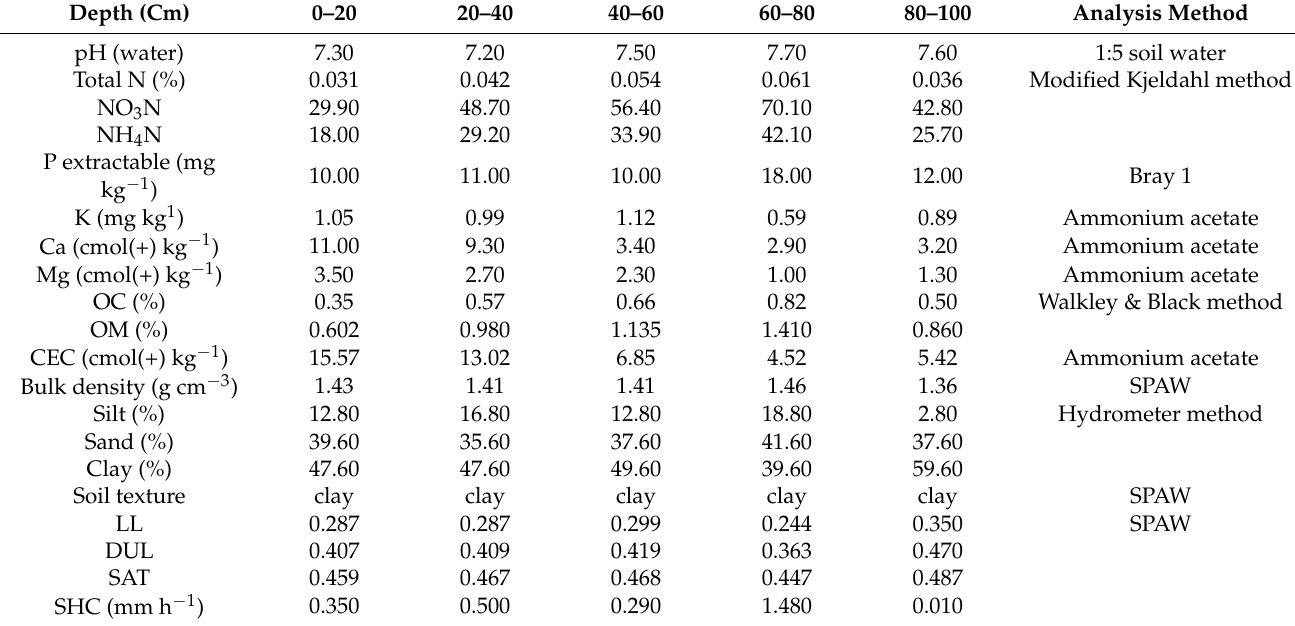
Table 1. Physical and chemical soil analyses under rainfed conditions. Reproduced with permission from